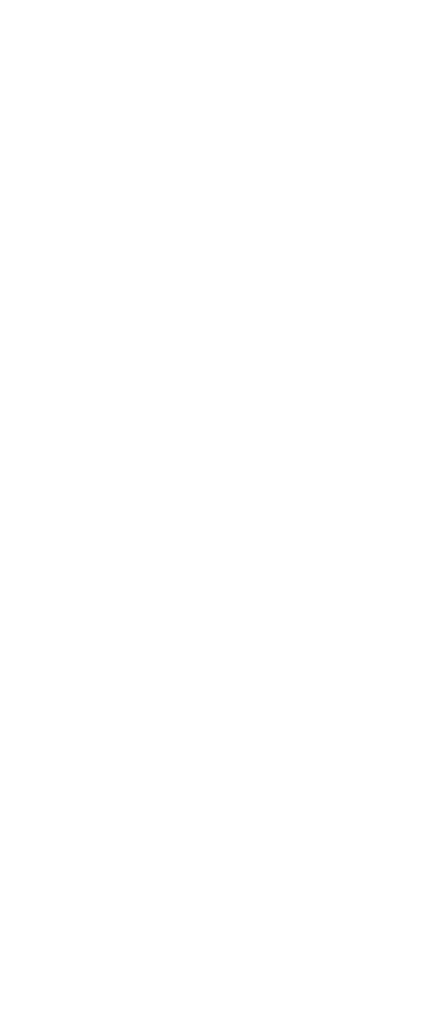
FIGURE 2 | Forest plots of IL-10-1082A/G(rs1800896) polymorphism and PTB. The allele model (G vs A), recessive model (GG vs. AA+AG), dominant model (AG +GG vs AA), co-dominant model (AG vs. AA) and over-dominant model (AA+GG vs. AG). The count for genotypes, weight, OR, 95% con fi dence interval for each study. The fi xed effect and random effect models were respectively utilized according to